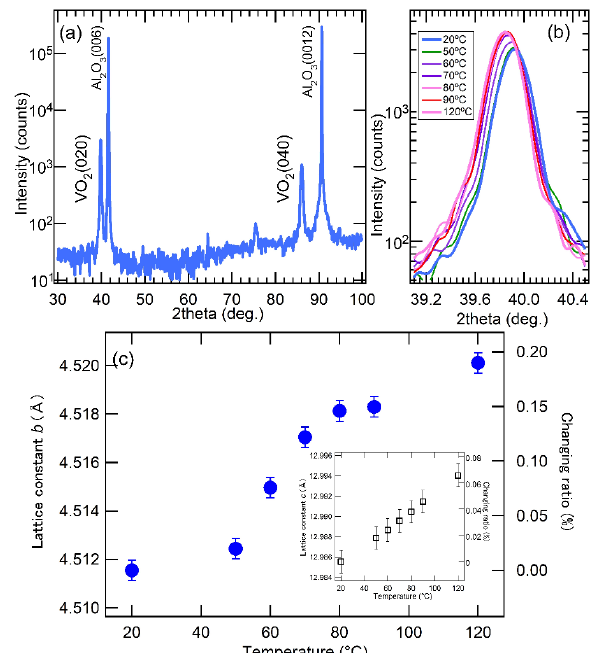
Figure 2. ( a ) XRD θ –2 θ scan for VO 2 film on Al 2 O 3 (0001) substrate at 20 ◦ C. ( b ) VO 2 (020) di ff raction peak at various temperatures. ( c ) Temperature-dependent lattice constant b of the VO 2 film. The inset shows the lattice constant c of Al 2 O 3 , which monotonically increases with temperature. A small peak at ~75 ◦ in ( a ) corresponds to Ni alloys in the sample holder.